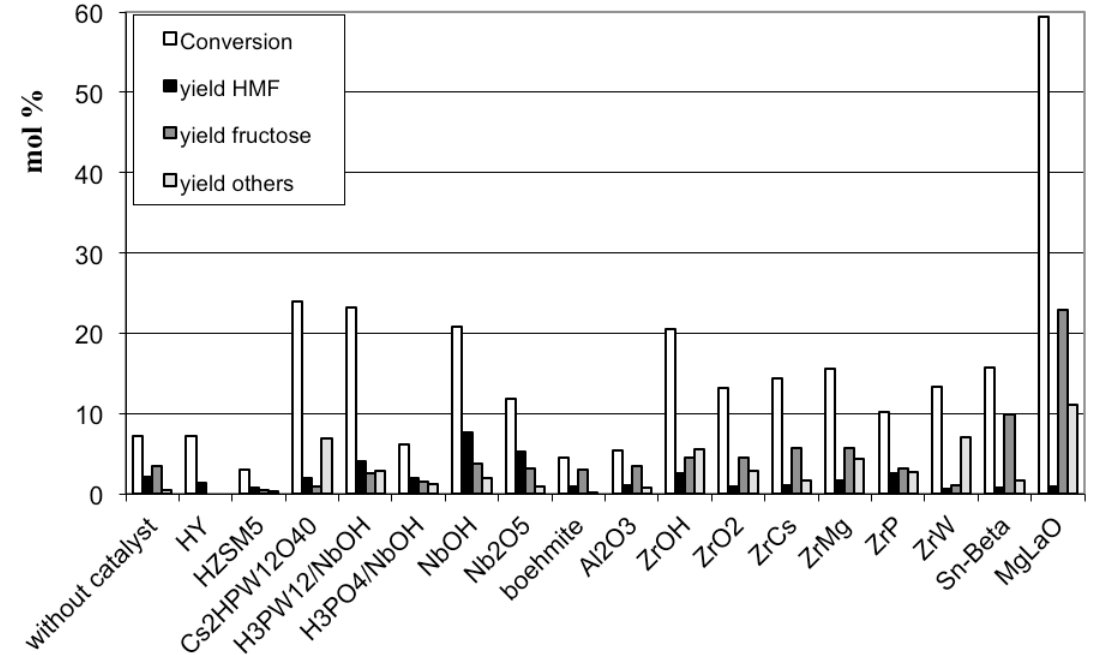
Figure 4. Glucose conversion in aqueous media at 150 °C in the presence of various 1 acid-basic solid catalysts together with amphoteric Zr and Al-based